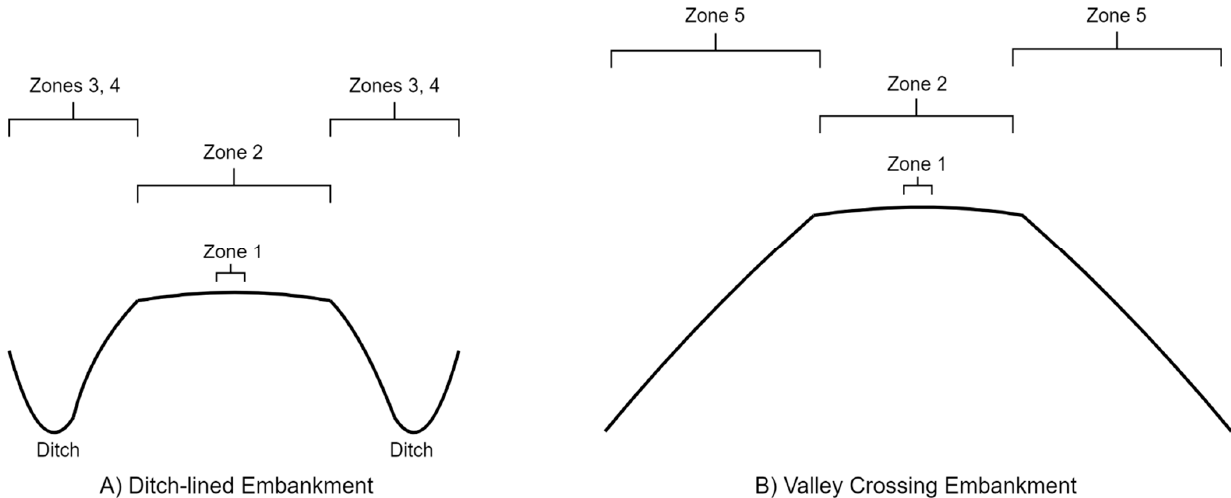
Figure 1. ( A ) Cross-sections of a ditch-lined embankment and corresponding embankment zones; ( B ) An embankment at a valley crossing and the corresponding embankment zones. These cross-sections are idealized conceptual profiles and not derived from real embankments.